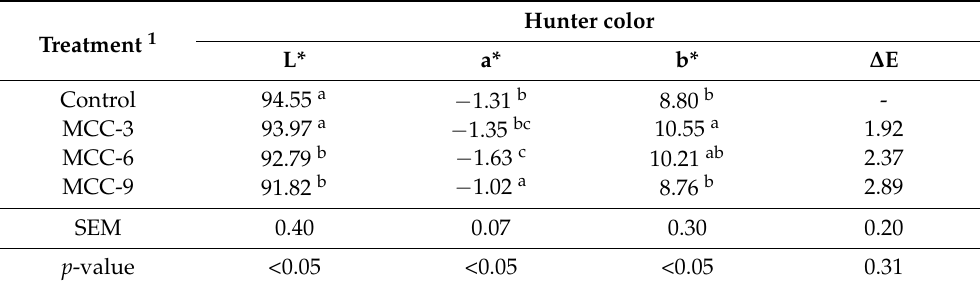
Table 5. Mean (n = 3) Hunter color (L*, a*, and b*) values of Feta-type cheese made from micellar casein concentrate